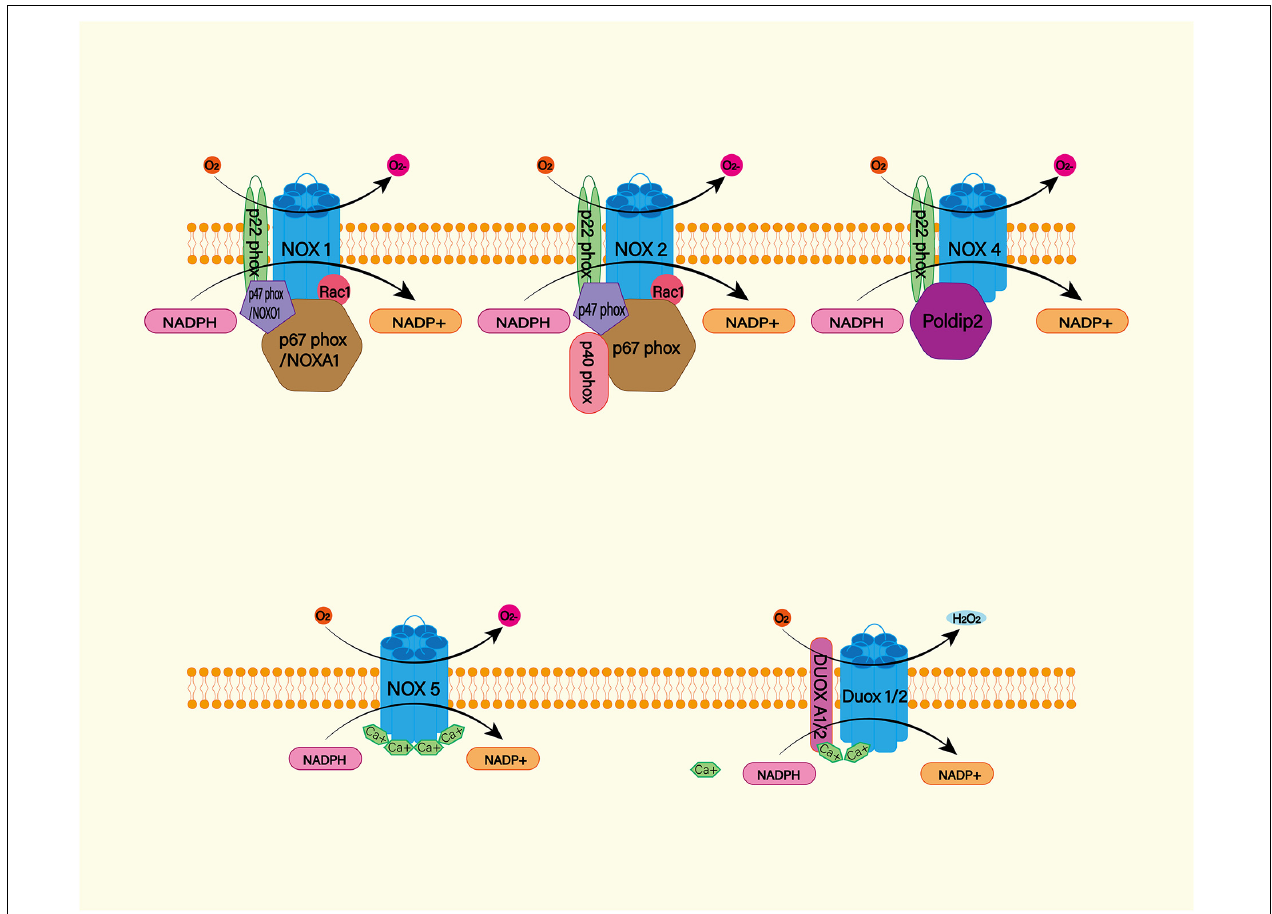
FIGURE 4 | The NADPH oxidase (NOX) family consists of seven catalytic subunits (NOX1-5 and DUOX1-2), regulatory subunits p22Phox, P47Phox or Noxo1, P67phox or Noxa1, and P40phox and Rac. They are widely expressed in endothelial cells (EC), vascular smooth muscle cells (VSMC), macrophages and other cells. Specifically, NOX1, 2, 4, and 5 are highly expressed in cardiovascular tissues. NOX – mediated ROS production mainly occurs on catalytic subunit Nox or Duox. For Nox1 and Nox2, ROS production requires complex interactions of regulatory subunits in the cytoplasm. Nox4, on the other hand, requires protein termed δ -interacting protein 2 (Poldip2). In addition, the increase in intracellular calcium was sufficient to promote the activation of NOX5 and